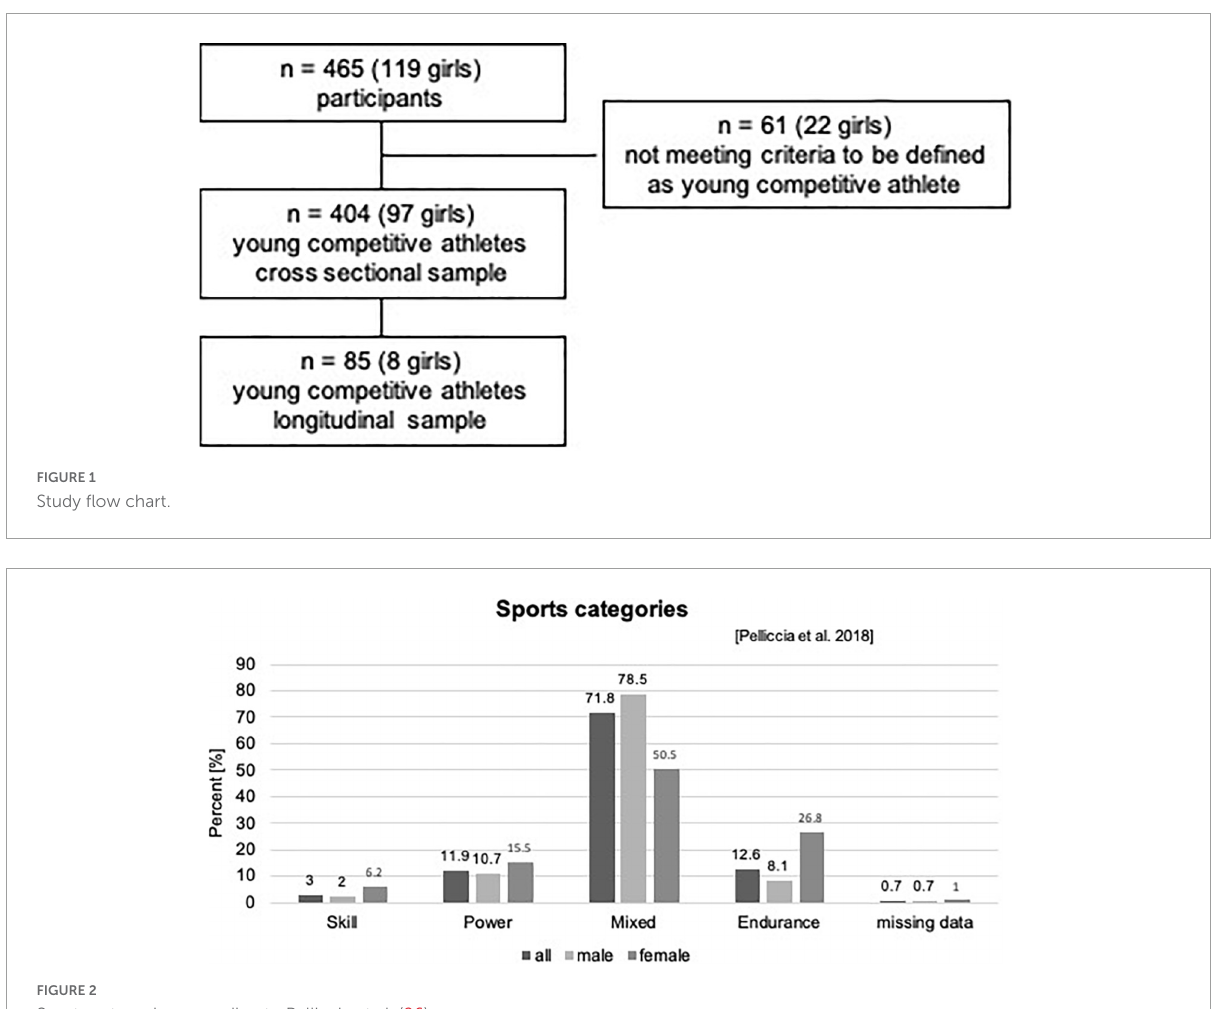
FIGURE2 Sports categories according to Pelliccia et al.